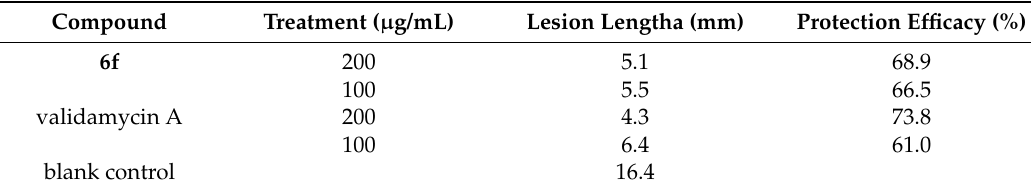
Figure 3. Protective activity of 6f against rice sheath blight (RSB). Table 3. Protective activity of 6f against RSB a .